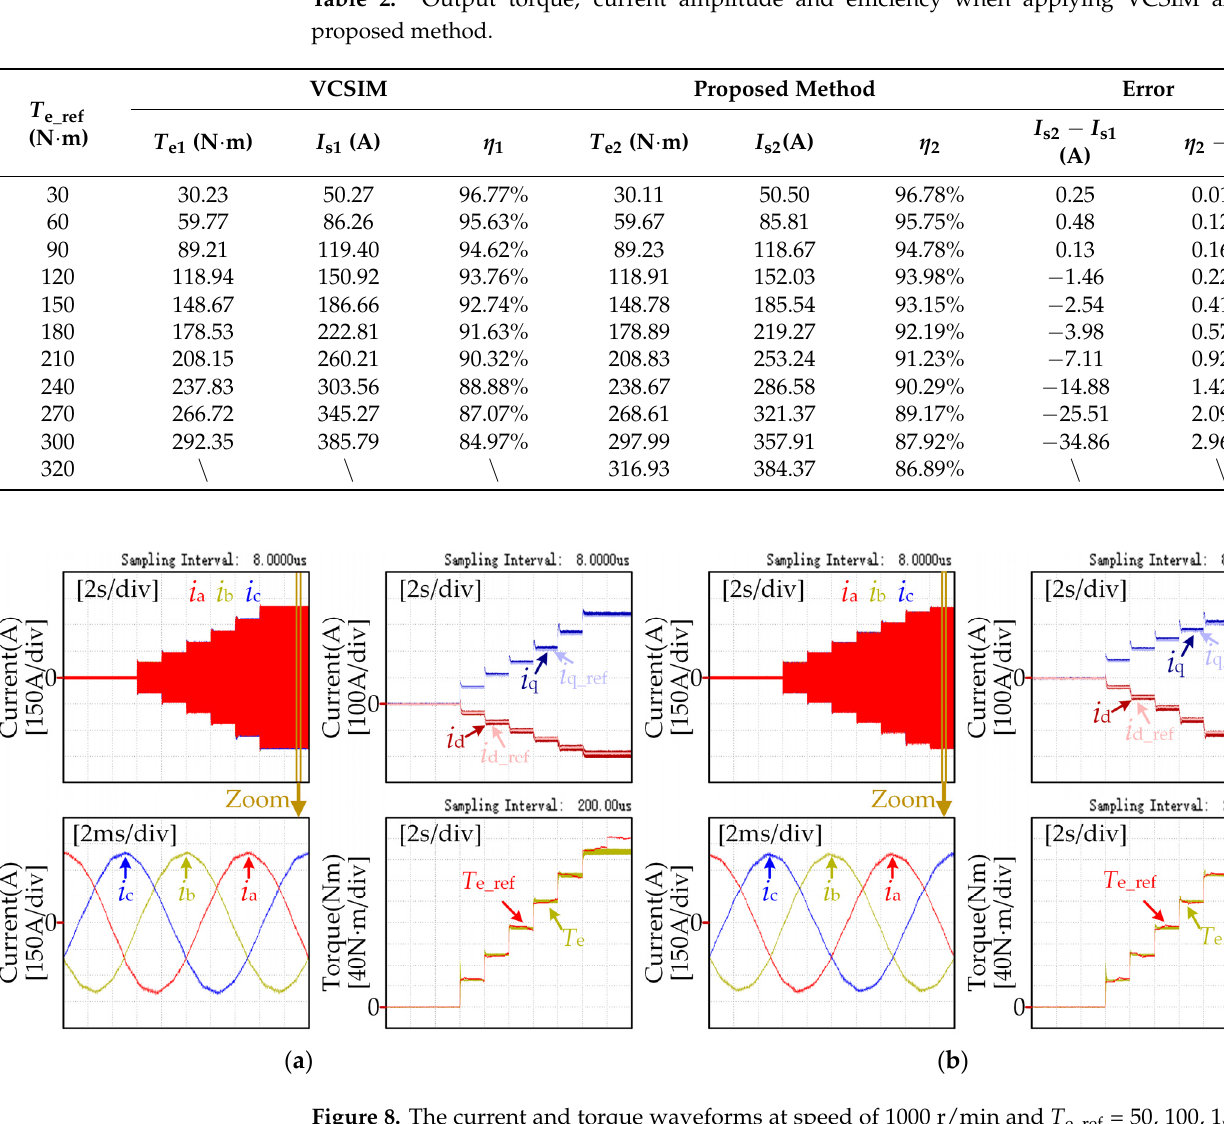
Figure 9. The current and torque waveforms at speed of 3000 r/min and T e_ref = 50, 100, 150, 200, 250, 300, 320 N · m: ( a ) VCSIM; ( b ) the proposed method.